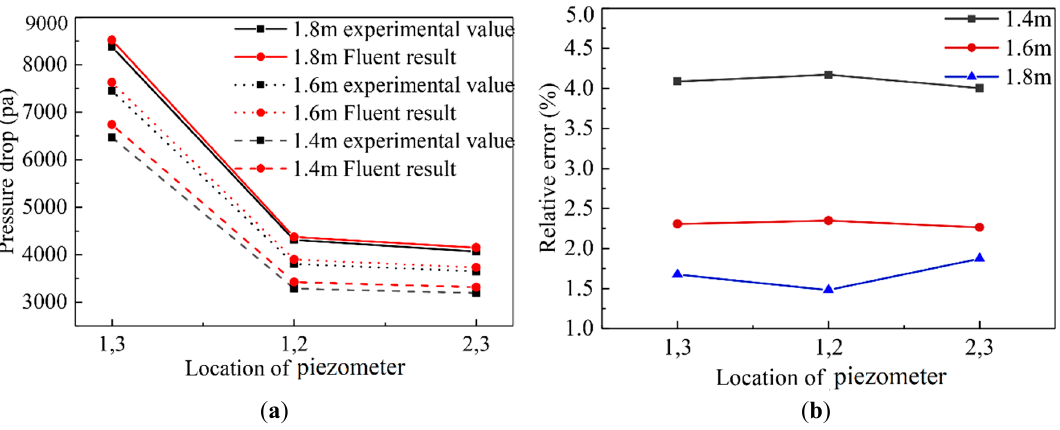
Figure 7. Comparison of falls in pressure between the experimental and simulation models. ( a ) Comparison between experimental and simulated values; ( b ) relative error value of each head. Table 3. Table of simulated working conditions of groove structure